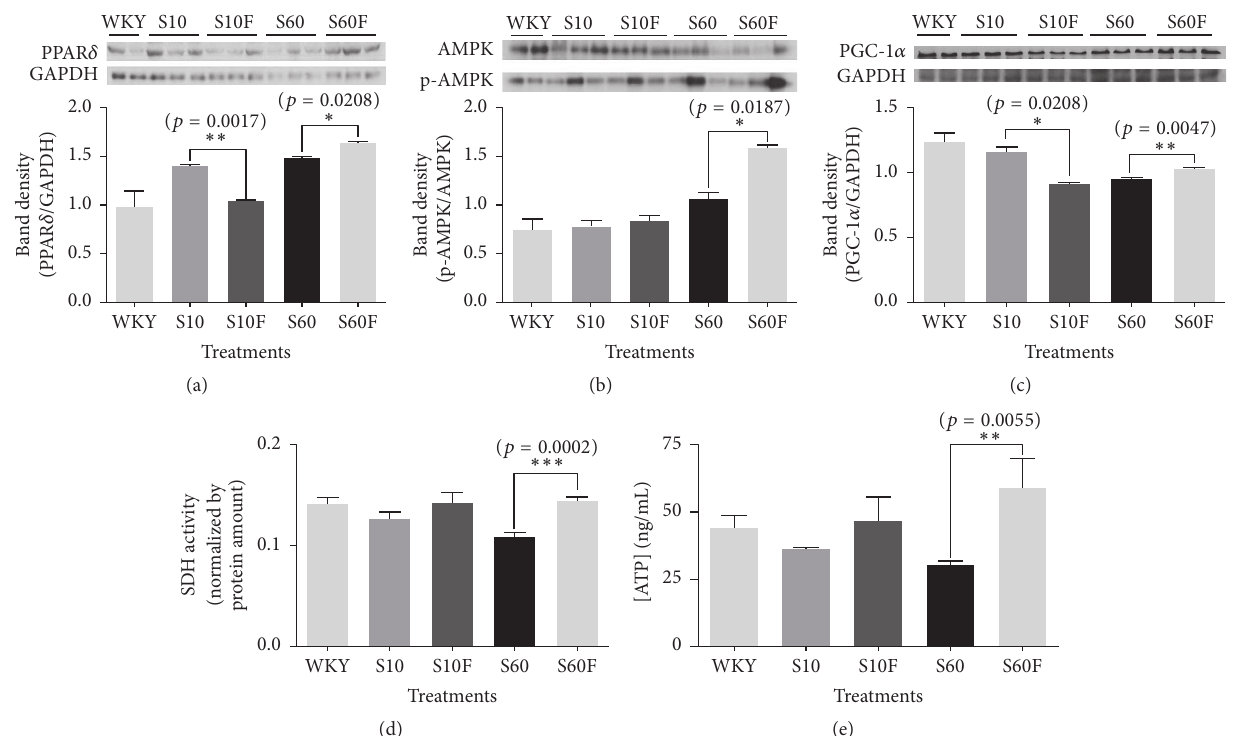
Figure 5: Peroxisome proliferator-activated receptor delta (PPAR 𝛿 ), 5 󸀠 adenosine monophosphate-activated protein kinase (AMPK), and peroxisomeproliferator-activatedreceptorgammacoactivator1-alpha(PGC-1 𝛼 )proteinexpressions,succinatedehydrogenase(SDH)activity, andadenosinetriphosphate(ATP)concentrationinlivertissuesofinWKYratsandSHRsgivenhigh-fatdietandfimasartan. ((a),(b),and(c)) Protein extracts were electrophoresed in 10% polyacrylamide gel and blotted to nitrocellulose membrane. The nitrocellulose membrane was bound with primary and secondary antibodies sequentially, and then the chemiluminescent signal was exposed to X-ray film. The density of bands on X-ray film was analyzed with ImageJ program. (d) The SDH activity was assayed by enzymatic colorimetric method. (e) The concentration of ATP in liver extracts of WKY rats and SHRs was estimated with ATP ELISA assay kit. The results are expressed as means ± SEM ( 𝑛 = 3 or 6). Values were statistically analyzed by unpaired t -test. All experiments were repeated three times. Meaning of indications: WKY means normal control rat given normal diet containing 10% fat, S10 means SHRs given normal diet containing 10% fat, S10F means SHRs given normal diet containing 10% fat plus fimasartan, S60 means SHRs given high-fat diet containing 60% fat, and S60F means SHRs given high-fat diet containing 60% fat plus